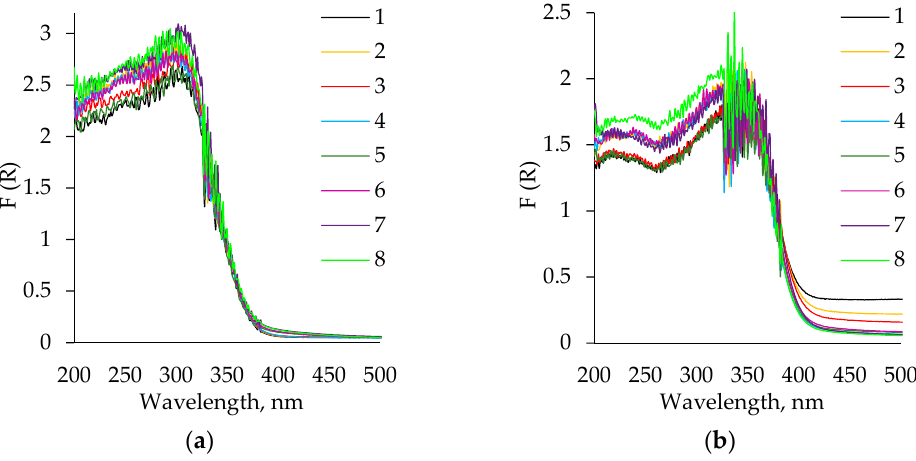
Figure 11. Diffuse reflectance spectra of TiO 2 aerogel powders: ( a ) before calcination; ( b ) after calcination. 1–4 curves correspond to precursor TBOT and 5–8 to TIP; 1, 3—without aging and solvent exchange; 2, 4—aged, without solvent exchange; 5, 7—unaged, nH exchanged; 6, 8—aged, nH exchanged.